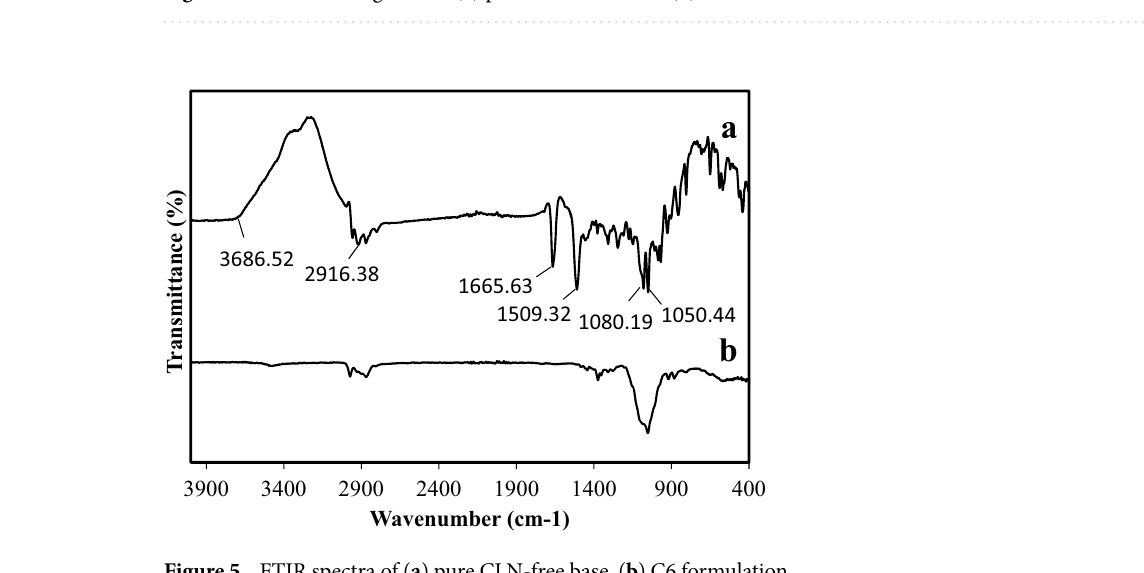
Figure 4. DSC thermograms of ( a ) pure CLN-free base, ( b ) C6 formulation.